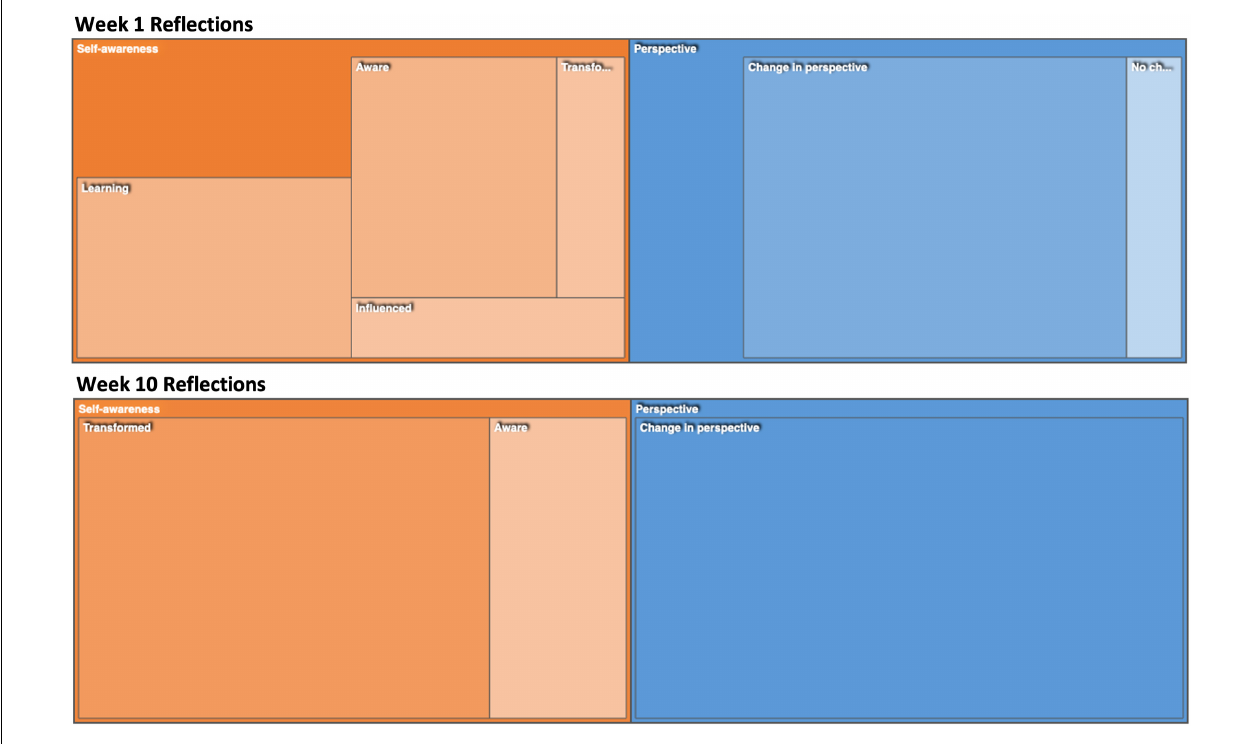
FIGURE 4 | Changes from Week 1 (beginning of term) to Week 10 (end of term) in coding categories for perspectives and self-awareness coding in weekly reflections. Awareness is defined as self-examination and a critical assessment of assumptions (second and third phases of the transformative learning process). Transformed is defined as the recognition of connection between one’s discontent and transformation process and exploration of options for new roles, relationships, and action [fourth and fifth phases of the transformative learning process as defined by Mezirow (2010)]. TABLE 6 | Select quotes from Week 10 reflections articulating transformative learning through key takeaways from the course. Key